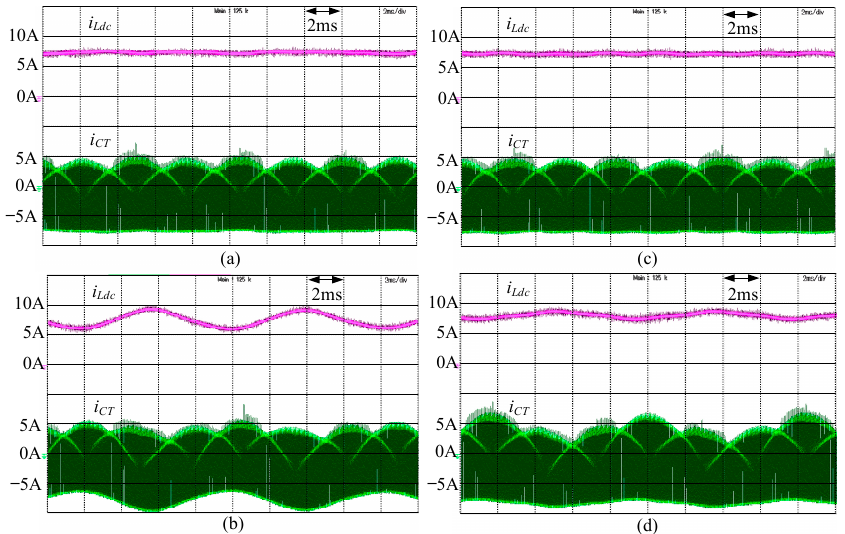
Figure 13. The measured waveforms of the low-voltage-side dc current i Ldc and the testing capacitor current i CT for ( a , c ) balanced and ( b , d ) unbalanced load conditions in the ( a , b ) conventional down-scale voltage rating evaluation system, and ( c , d ) proposed down-scale voltage rating evaluation system.